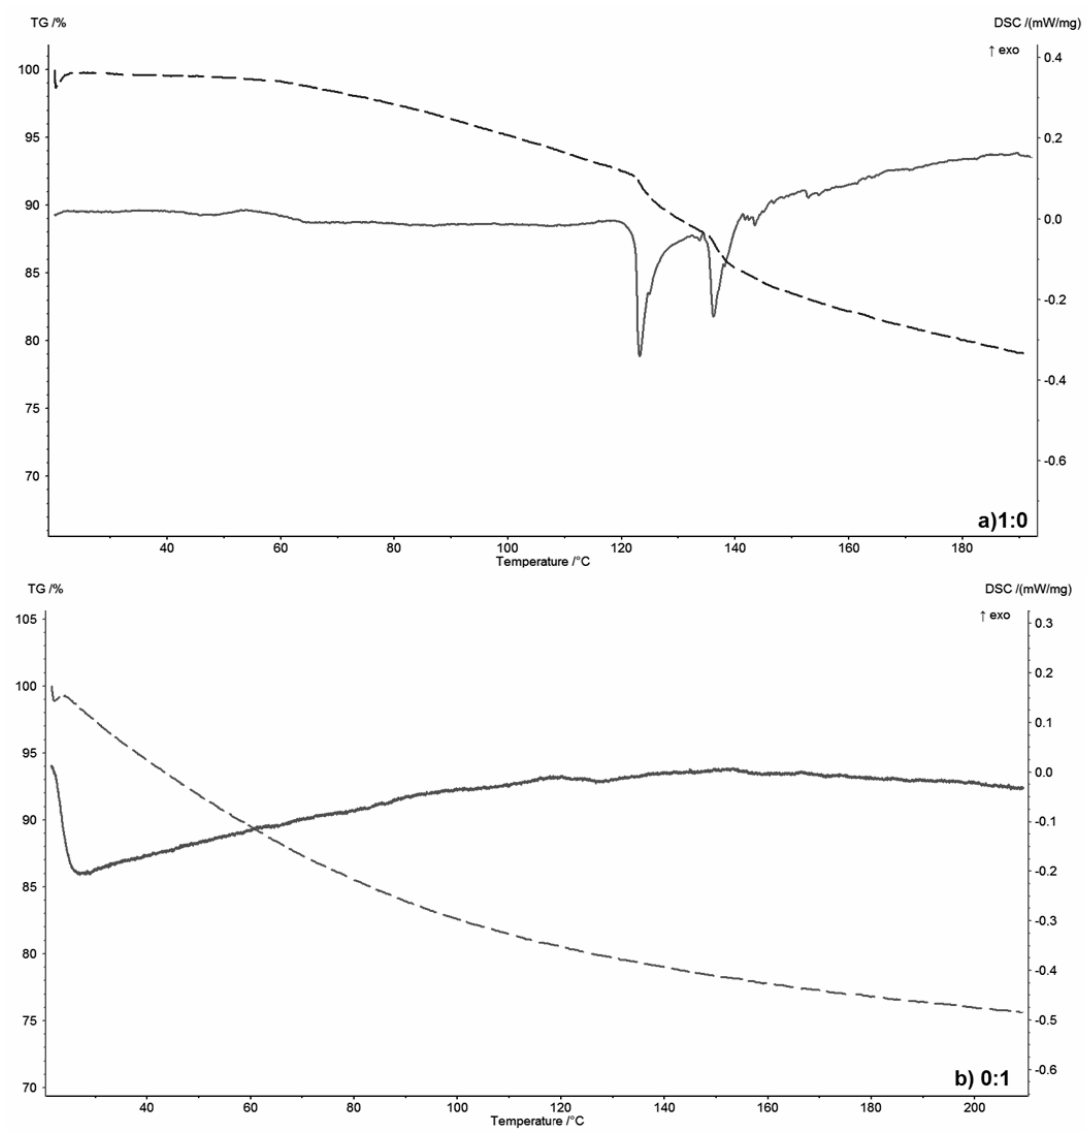
Figure 3. TG / DSC thermograms of the pure components: ( a ) R-150 sodium water glass (1:0), ( b ) sodium polyacrylate (0:1).